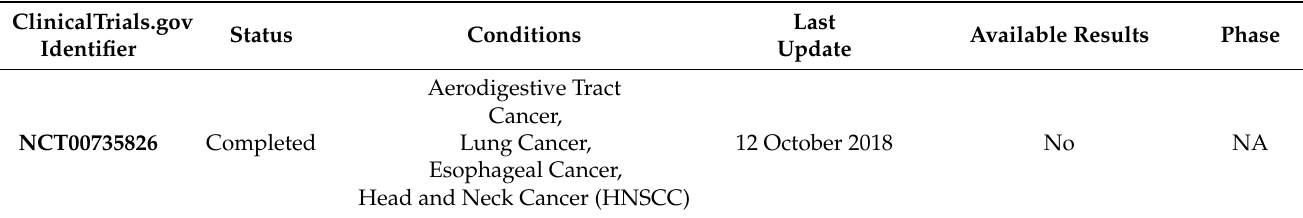
Table 4. Clinical trial for the use of SAHA in oncology